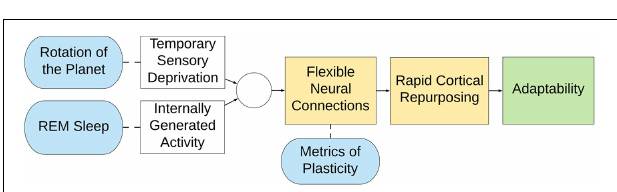
FIGURE 6 | Summary representation of the defensive activation theory. (Yellow) Flexible neural connections lead to rapid cortical repurposing, endowing a species with immense adaptability (green) because of dynamic cortical allocation (Blue). However, because of the rotation of the planet animals experience temporary, cyclical deprivation of vision, and therefore REM sleep is proposed to counterbalance this disadvantage. Accordingly, animals are able to retain the territory of their visual cortex, even though it would otherwise go unstimulated for half of their